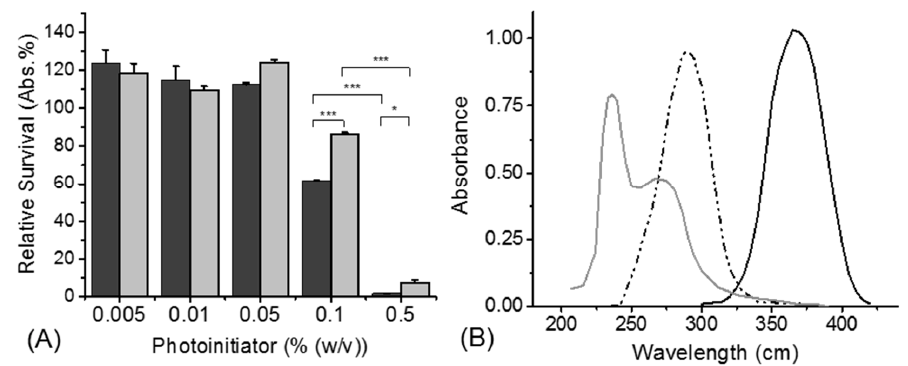
Figure 2. Initiator analysis ( A ) Relative survival of G292 cells cultured in cell culture medium supplemented with increasing initiator concentrations. I2959 ( ● ); LAP ( ● ). Cell survival was quantified using an ATPlite viability assay. Data are presented as means ± SEM. * p < 0.05; *** p < 0.001. ( B ) UV/Vis spectrum showing the absorbance of collagen, LAP and I2959 solutions. Collagen ( ⎯ ); I2959 ( - ⋅ - ); LAP ( ⎯ ).